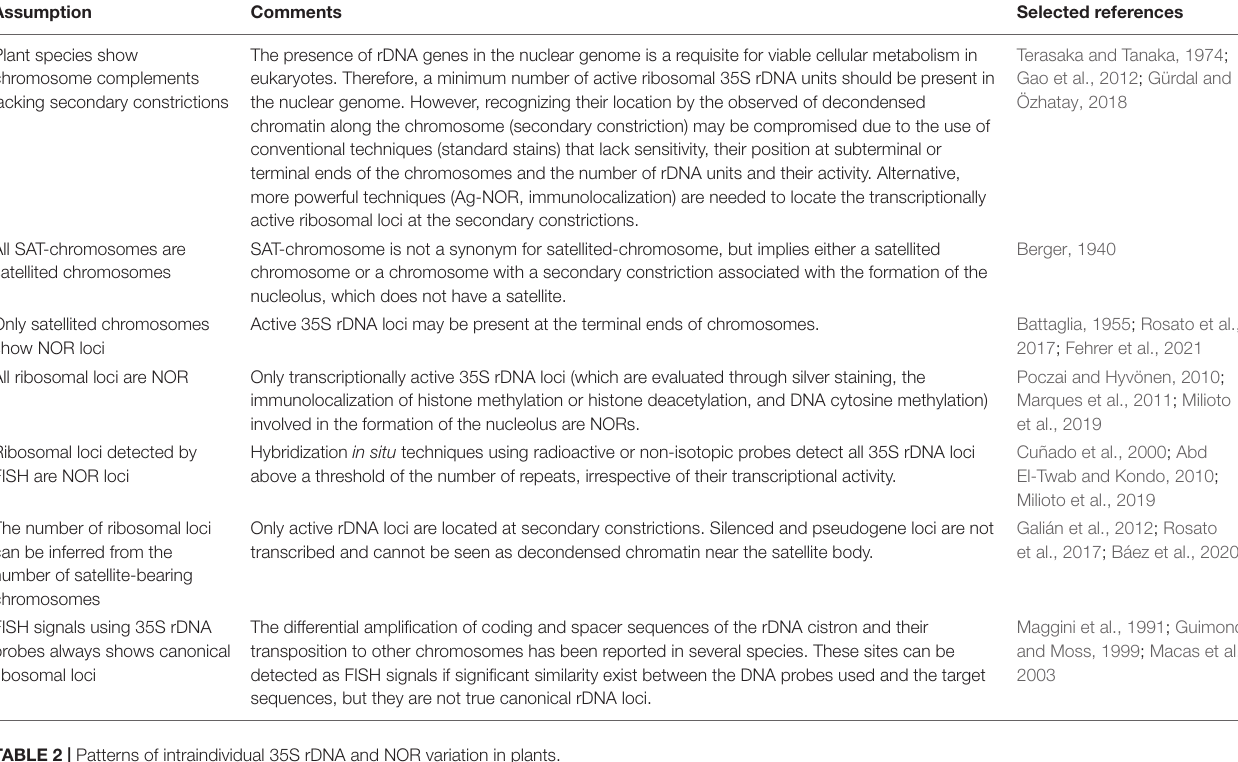
TABLE 1 | The nuclear 35S rDNA landmarks and significant terminology associated to its activity, detection and morphology. Assumption